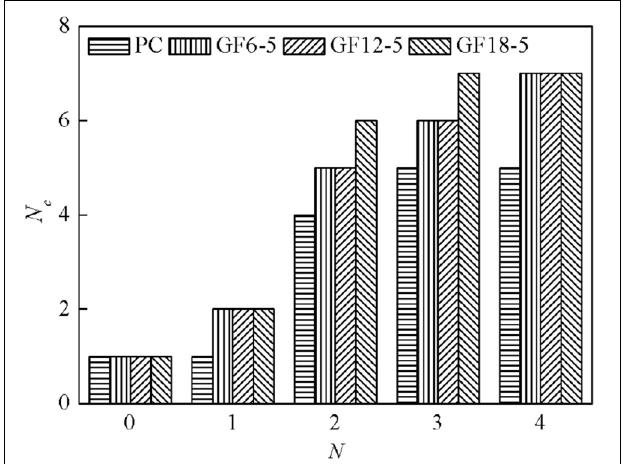
FIGURE 5 | Relationship between the number of cracks and textile layers.